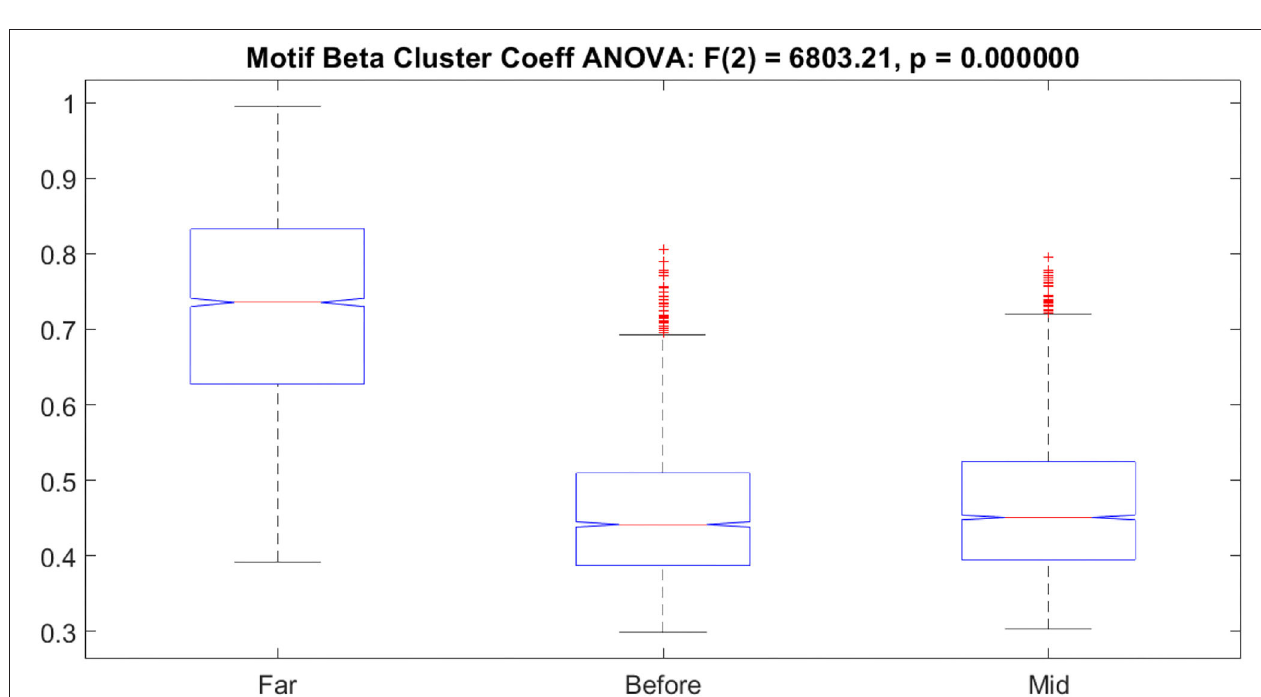
FIGURE 8 | Boxplot for global cluster coefficient obtained with the motif method applied to the beta band and corresponding ANOVA result, comparing distributions obtained from far, before, and mid 1s EEG segments.